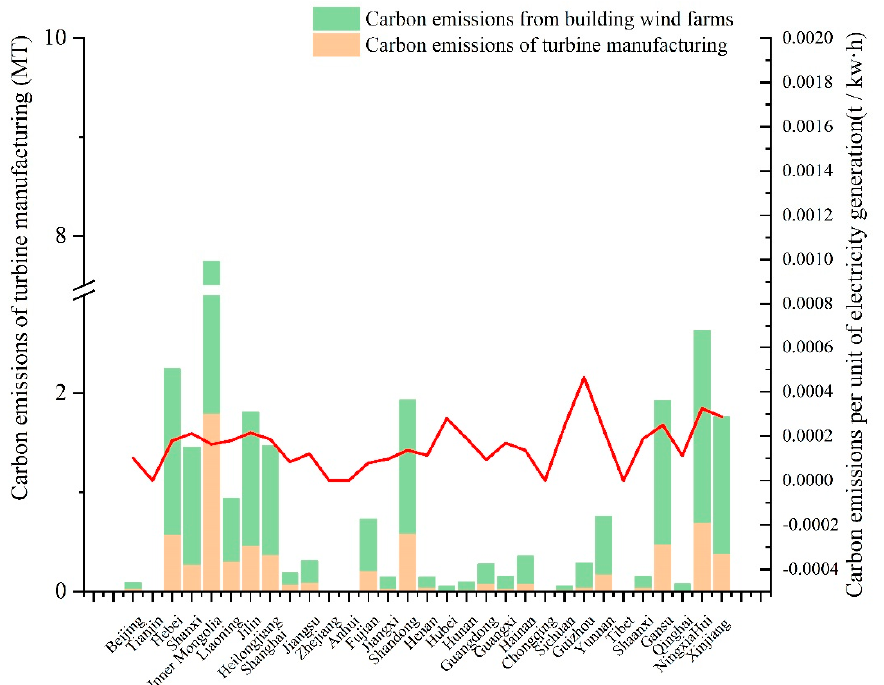
Figure 5. Total carbon emissions and emissions per unit of electricity generation in each province.